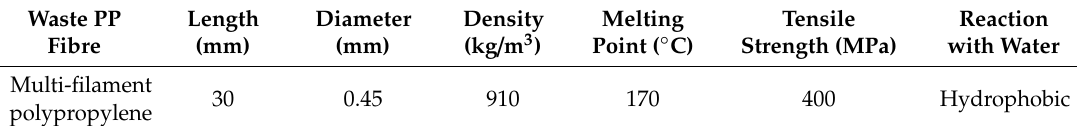
Table 2. Typical properties of fabricated polypropylene (PP) waste fibres.